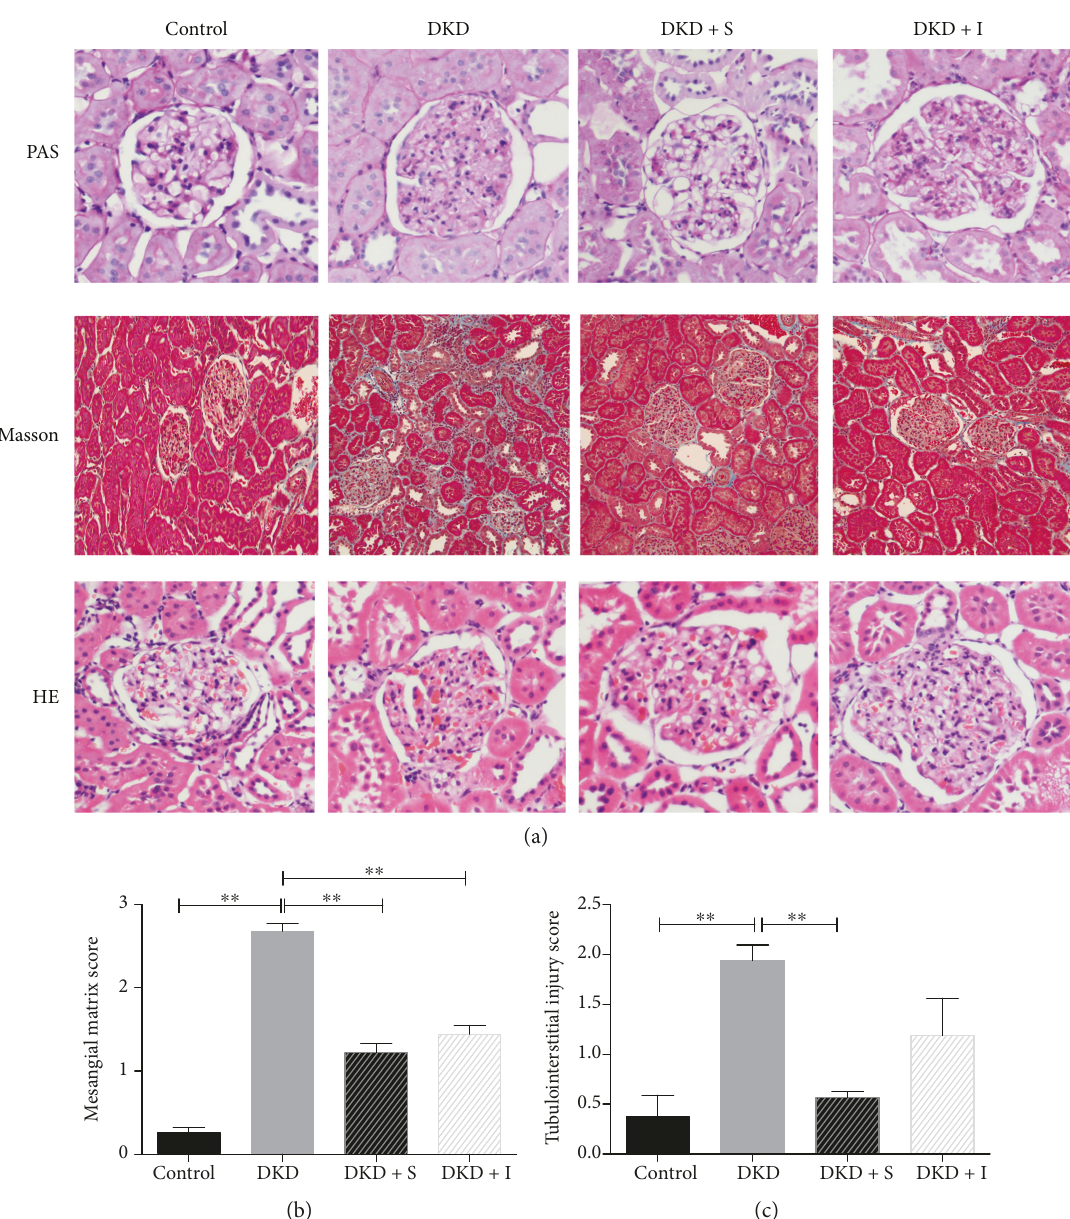
Figure 2: Histological study. (a) HE, PAS, and Masson staining was shown. (b, c) Semiquanti fi cation of the mesangial matrix score and the tubular interstitial injury score is presented. DKD +S represents the DKD rats treated with SYFSF. DKD+ I represents the DKD rats treated with irbesartan. ∗∗ P < 0 01